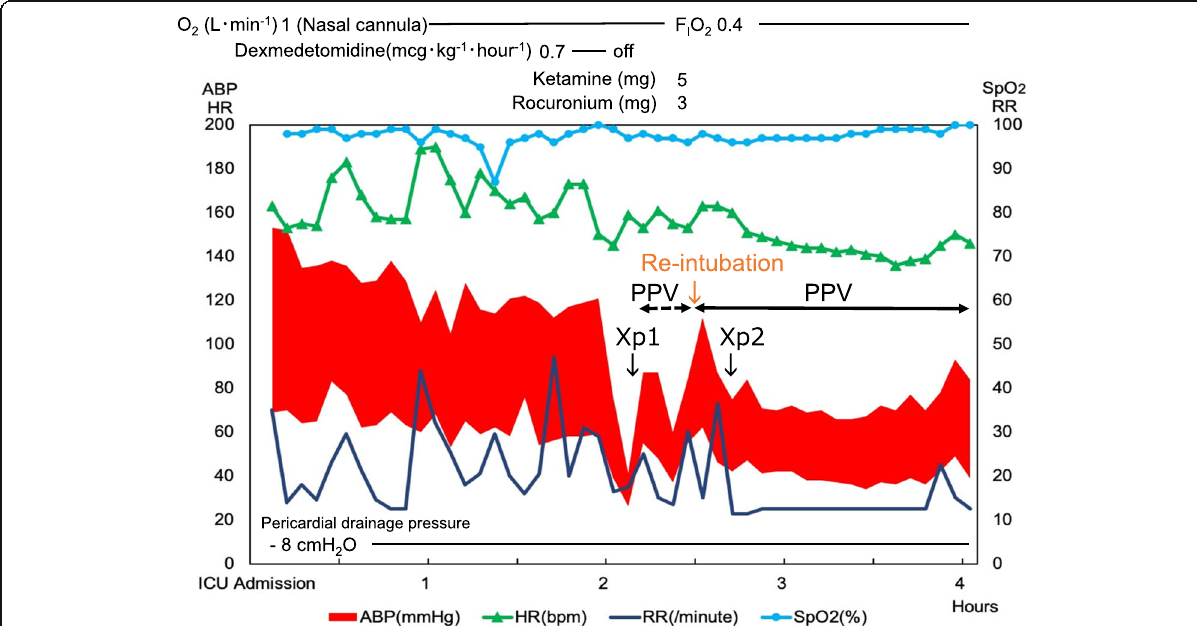
Fig. 2 Clinical course in the intensive care unit. O 2 , oxygen; F I O 2 , fraction of inspiratory oxygen; ABP, arterial blood pressure; HR, heart rate; bpm, beats per minute; RR, respiratory rate; SpO 2 , peripheral oxygen saturation; PPV, positive pressure ventilation. The chest X-rays of Fig. 1 b and c were taken at the time shown as Xp1 and Xp2, respectively, in this